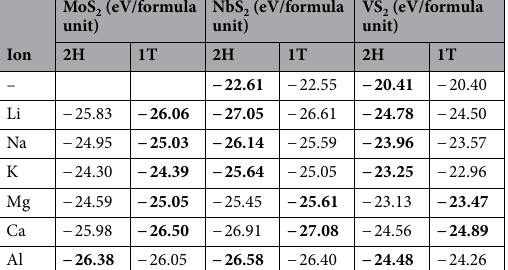
Table 1. The calculated energy of 2H and 1T phases of ion intercalated MoS 2 , VS 2 , and NbS 2 . The numbers in bold identify the lower energy phases of the TMDs in the presence of various intercalating